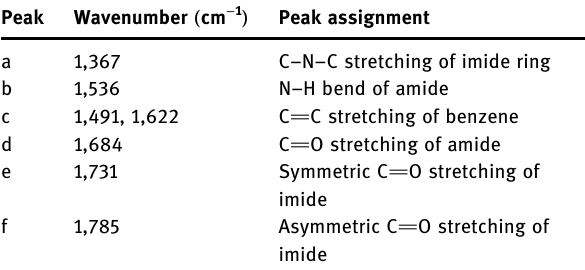
Table 3: FT - IR peak assignments for PI fi lm